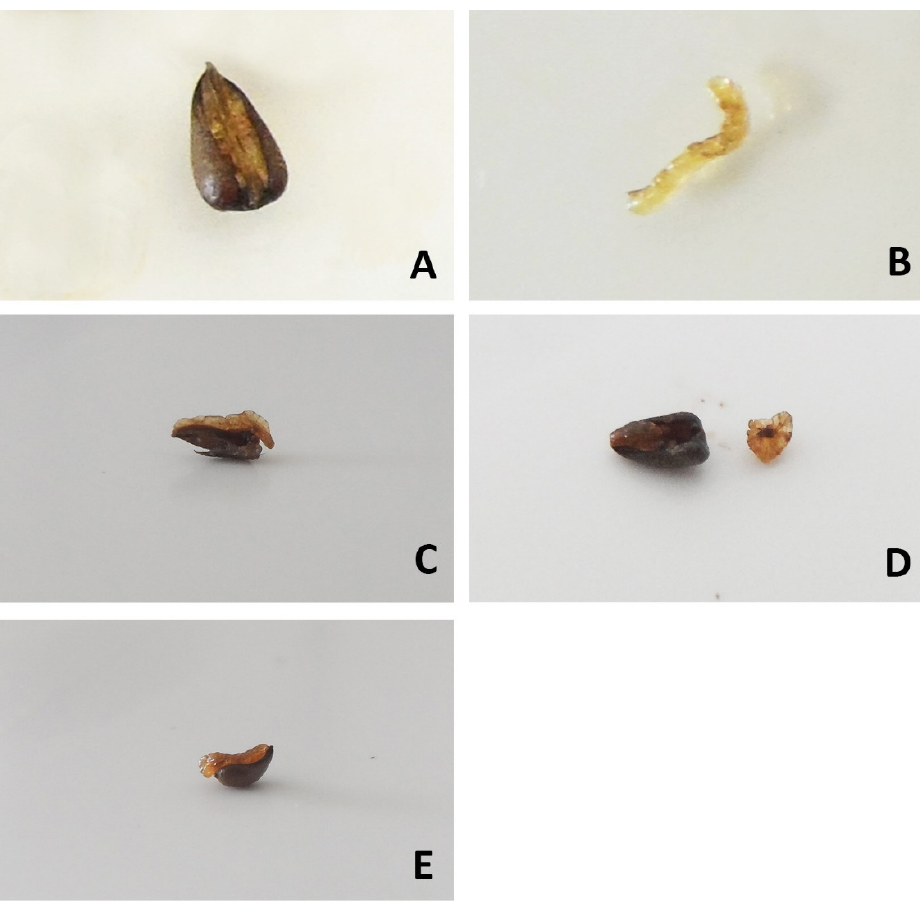
Figure 1. Examples of experimental treatments in the European wild ginger. Diaspore without elaiosome ( A ), elaiosome only ( B ), 1/2 diaspore + elaiosome ( C ), 1/2 elaiosome + diaspore ( D ) and control ( E ).